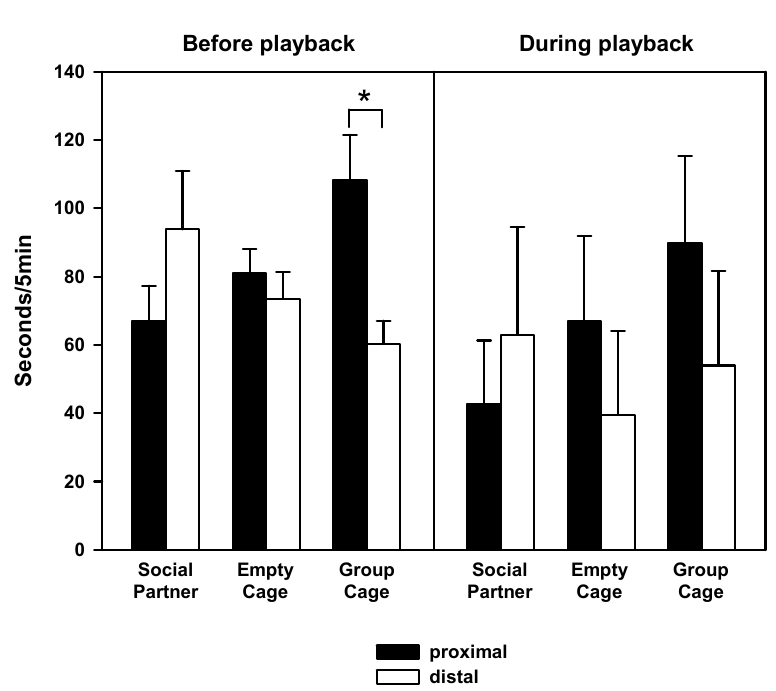
Figure 8. Proximal (black) or distal (white) arm times in the retest before ( left ) or during ( right ) playback of 50-kHz USV in animals, which had access to a conspecific (Social Partner), no social contact (Empty Cage) or their cage mates (Group Cage) immediately after playback in the initial test. Data are presented as means + SEM. * p < 0.05 for proximal versus distal values.